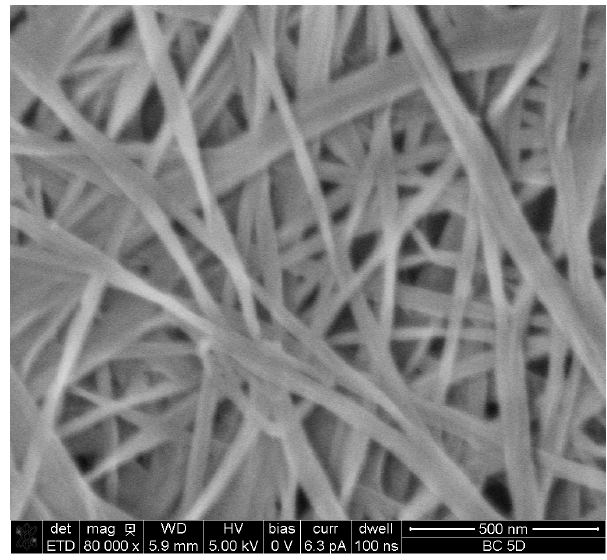
Figure 7. SEM image of BC harvested after 6 days (magnification 80,000×).